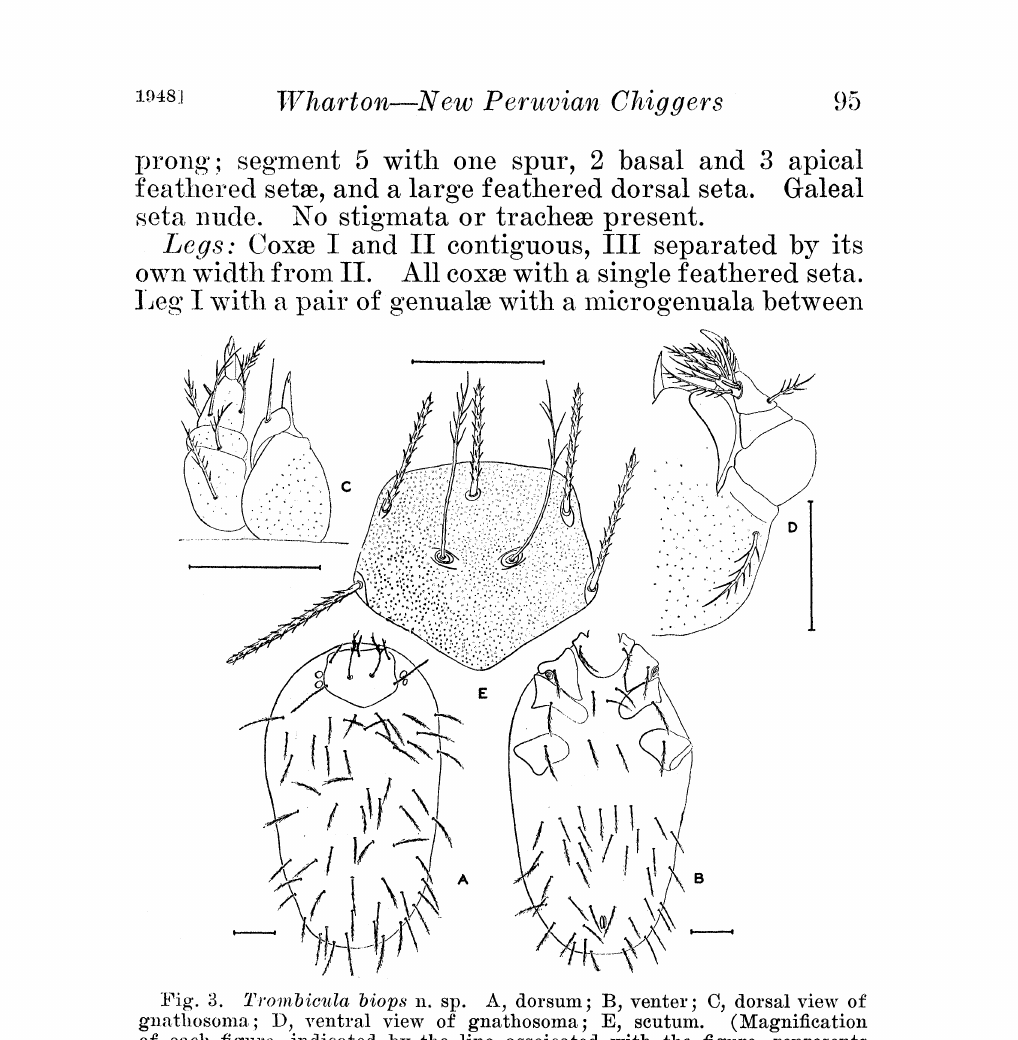
of each. figure, indicated by the line assoicated with the figure, represents 50